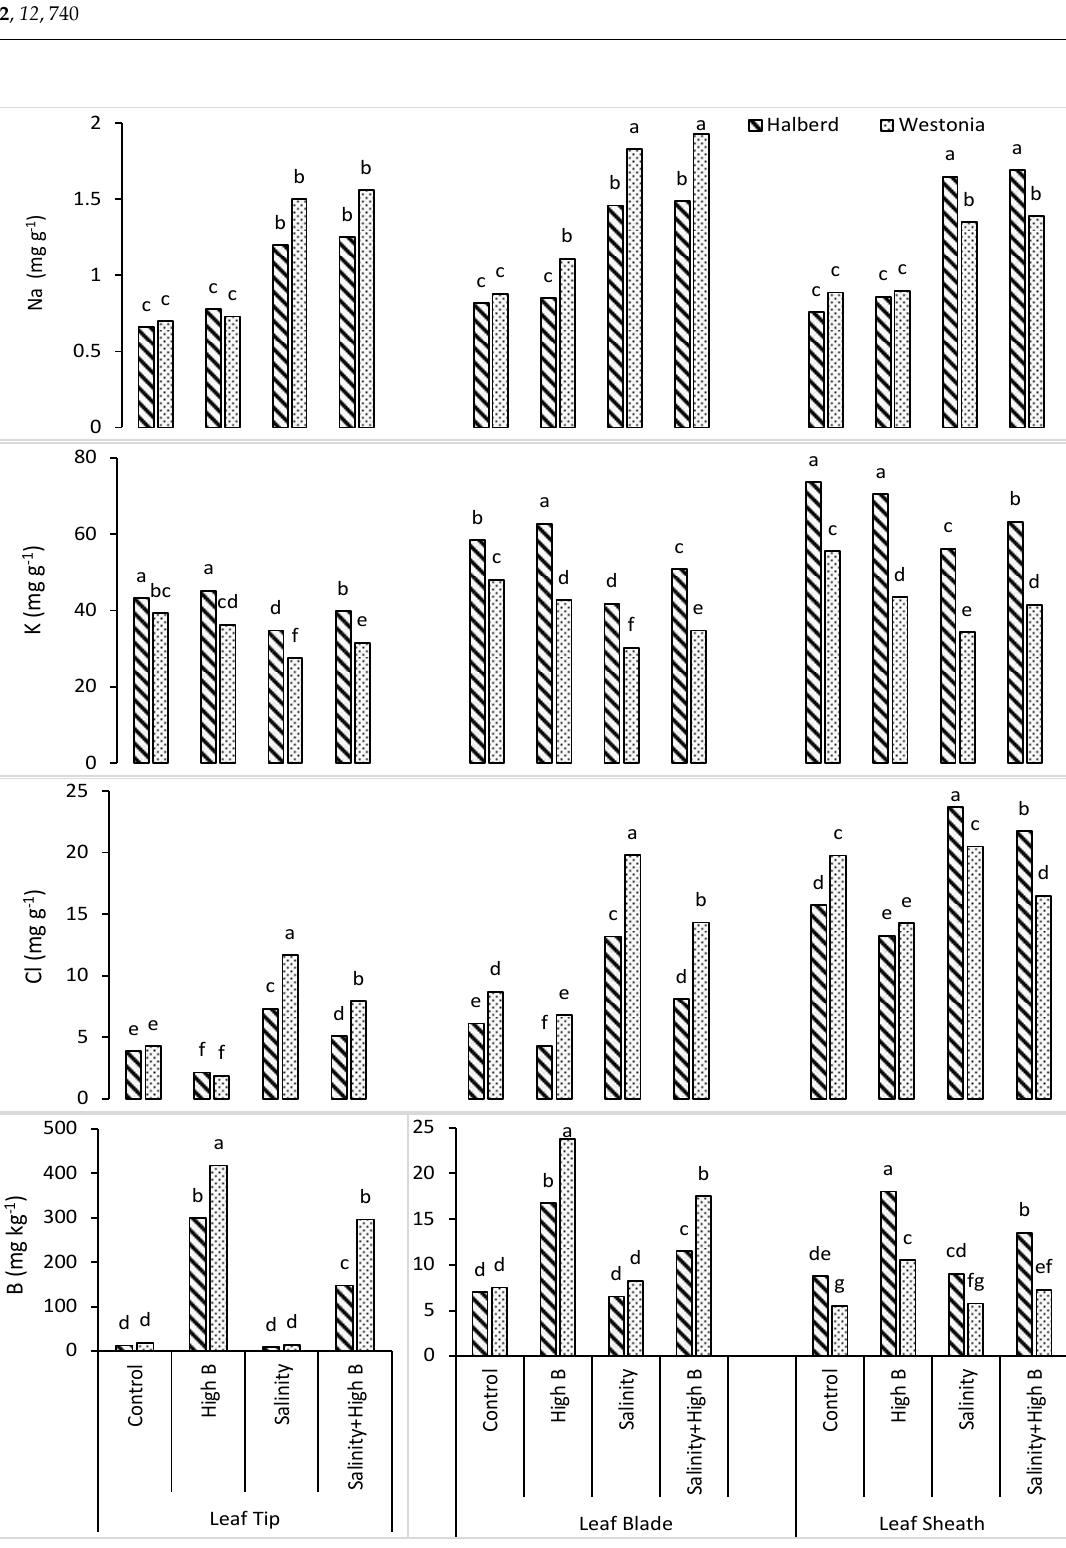
Figure 3. Impact of soil salinity and high B on Na, K, Cl, and B partitioning in wheat leaf (each value is a mean, n = 3 statistically significant at p ≤ 0.05, T bars represent ± standard error of means). Whereas, T 1 = control, T 2 = B at 7.5 mg kg − 1 (high B), T 3 = 15 EC dS m − 1 (Salinity), and T 4 = 15 EC dS m − 1 + B at 7.5 mg kg − 1 (Salinity + high B). Haldberd (HB), Westonia (WS).